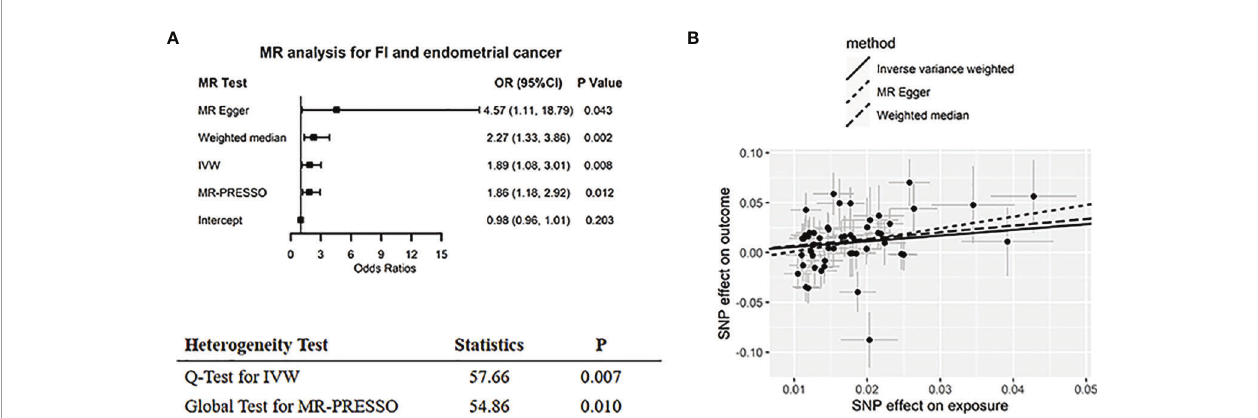
FIGURE 3 | Two-sample MR analysis results of FI on endometrial cancer. (A) Forest plot for summarizing the results of all MR methods. The black box represents the effect estimates, and the error line represents the 95% CI. (B) Scatter plot for comparison of MR methods. The black circle represents the point effect estimate, and the slope represents the correlation trend. FI, fasting insulin; CRC, colorectal cancer; MR, Mendelian randomization; IVW, inverse-variance weighted; MR- PRESSO, MR pleiotropy residual sum and outlier test; OR, odds ratio.